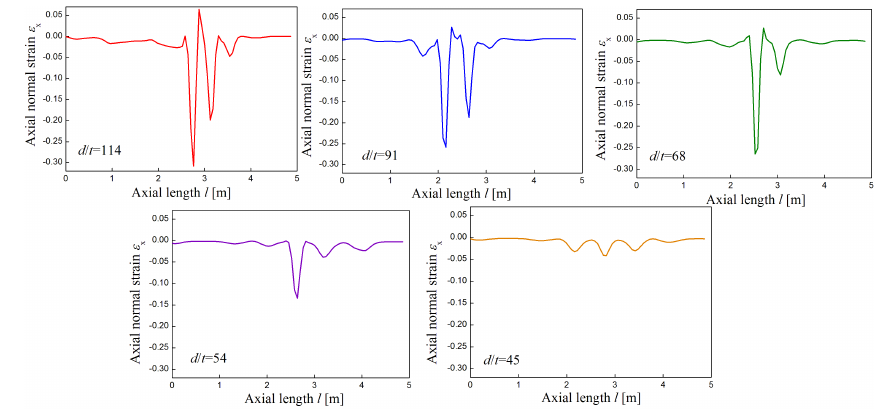
Figure 12. Variations of axial strain at the compression side of the buckling area under different diameter-thick ratios.